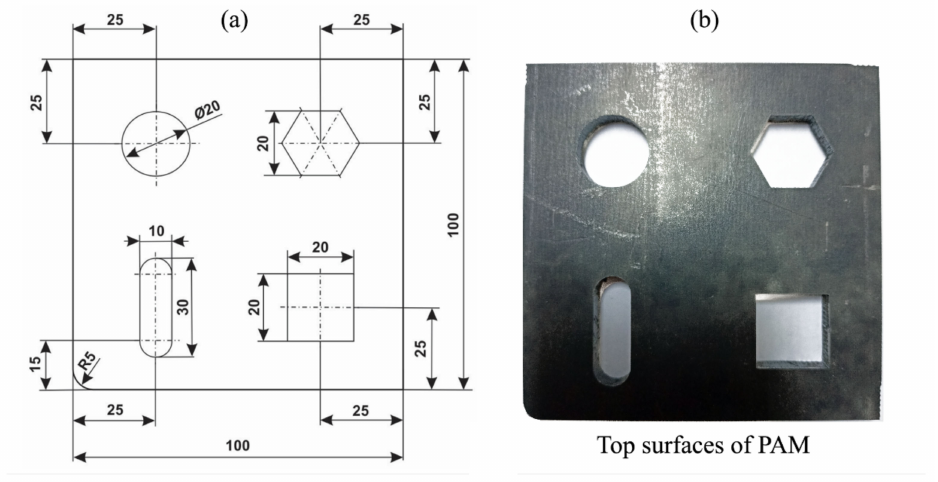
Figure 2. Basic geometric shapes for cutting: ( a ) 2D geometric shapes and ( b ) example of a PAM cut